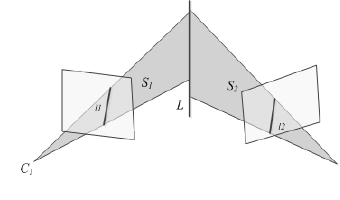
Fig.6 3D Reconstruction of Space Straight